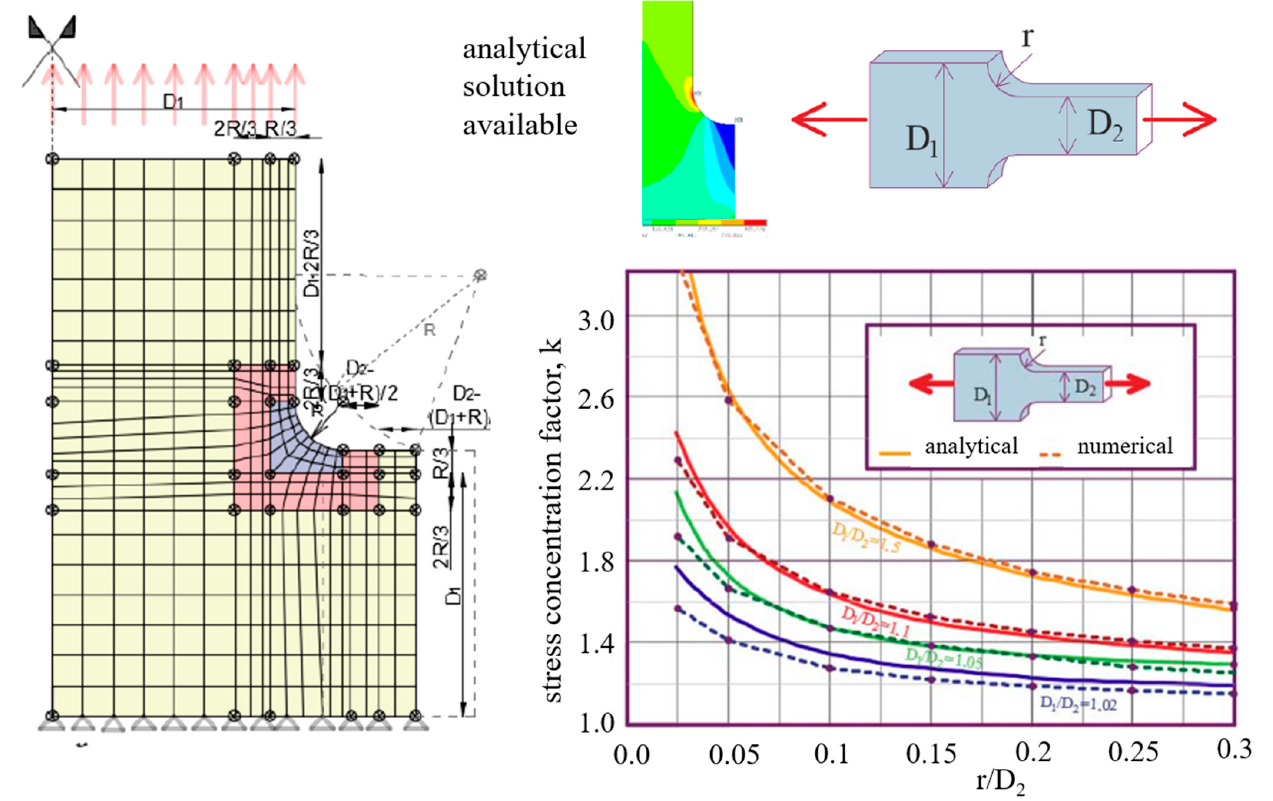
Figure 2. Comparison of analytically and numerically calculated stress concentration [12].